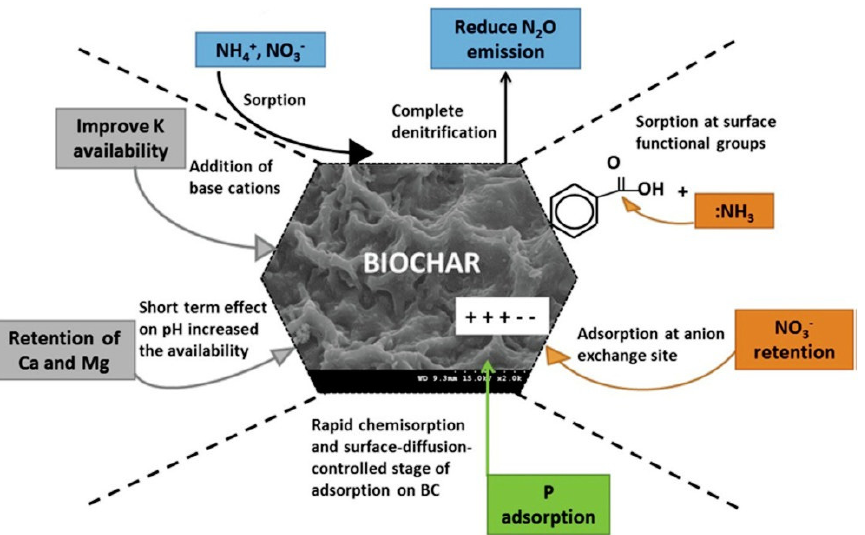
Figure 3. Schematic diagram representing how biochar improves the retention of nutrients and increases their availability in soils (Reprinted from Chemosphere, 227, Purakayastha, T.J. et al., A review on biochar modulated soil condition improvements and nutrient dynamics concerning crop yields: Pathways to climate change mitigation and global food security, 345–365, Copyright (2019), with permission from Elsevier.